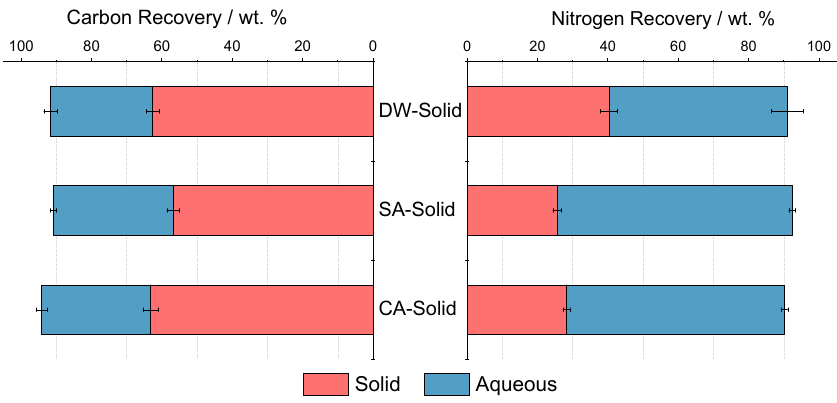
Figure 2. Carbon and nitrogen recovery in the solid phase and aqueous supernatant of hydrothermal pre-treatment.